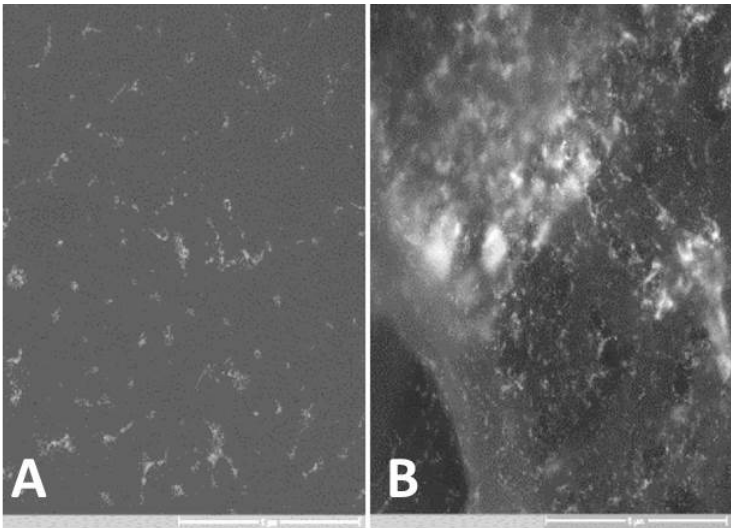
Figure 6. GNP-stained slide viewed with a high resolution (X19K) scanning electron microscope (airSEM ™ ). A significantly lower density of GNPs can be seen in the tumor-free tissue ( A ) in comparison to the SCC-containing tissue ( B ).